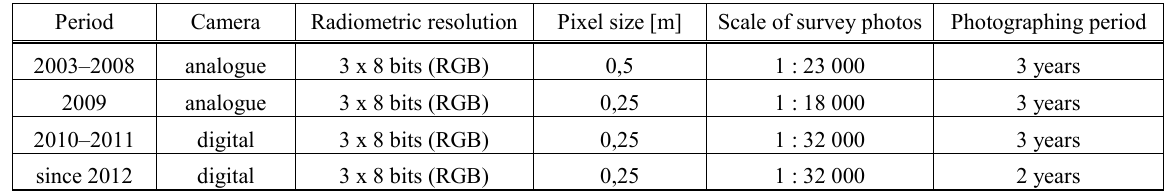
Table 1. Parameter of aerial survey photography for the creation orthophotos of the Czech